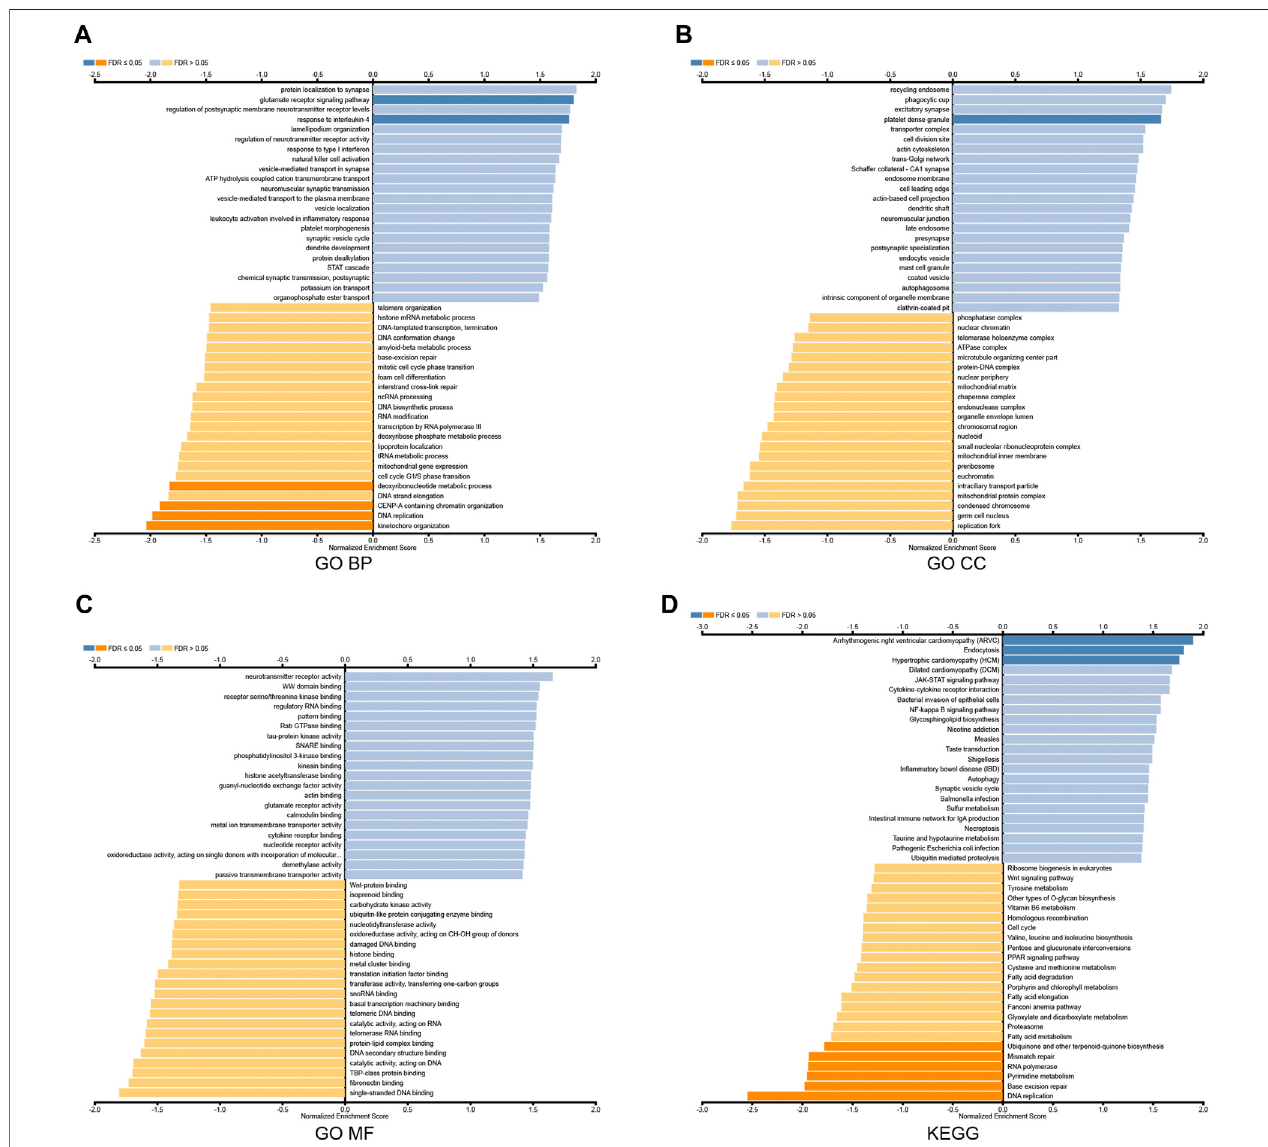
FIGURE3| EnrichmentanalysisofRAB39B co-expressiongenesinDLBCL. (A – C) RAB39B co-expressiongeneswereannotated byGOBP (A) ,CC (B) ,and MF (C) analysis. (D) KEGG pathway analysis of RAB39B co-expression genes.